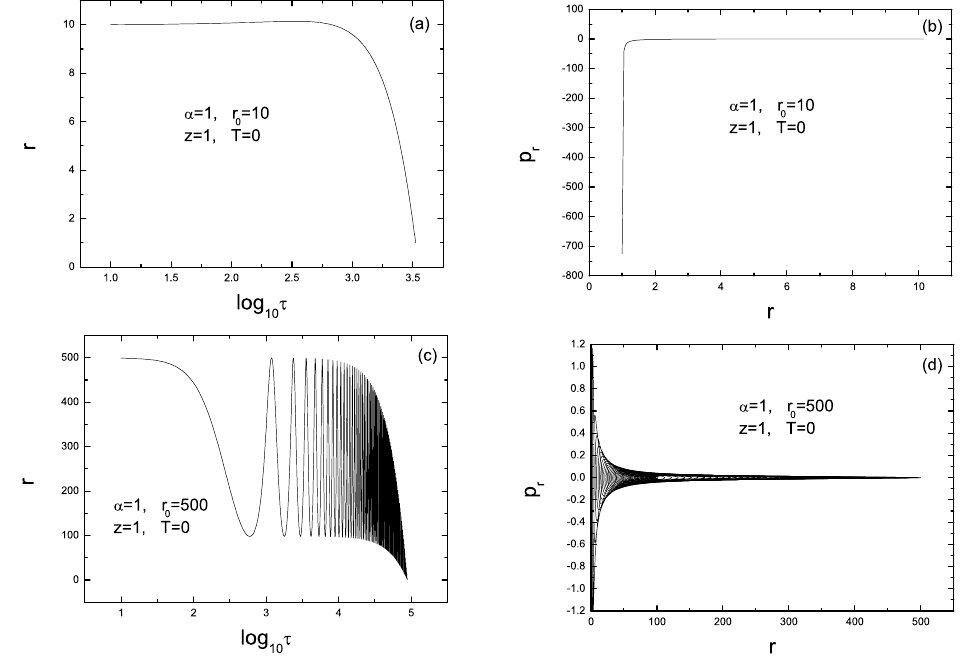
Figure 1 . The time evolution of r ( (cid:28) ) (left panels) and the phase space ( r; p r ) (right panels) with di(cid:11)erent initial conditions (the panels above are r 0 = 10 and that below are r 0 = 500) at T = 0. Here, we have set (cid:11) = 1, (cid:18) = 0, z = 1, E = 5, (cid:12) = 1 =(cid:25) , (cid:26) = 0 : 01 and p (cid:26) =